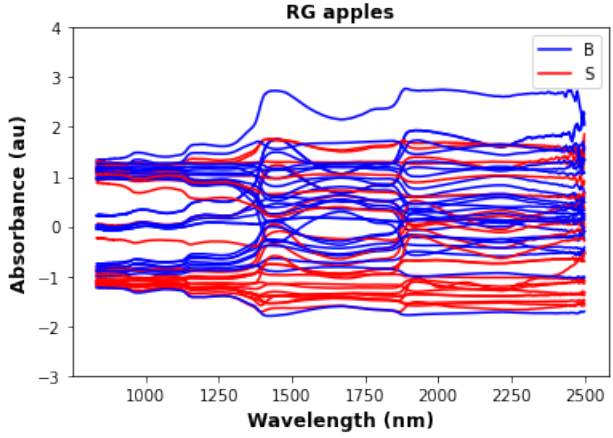
Figure 2. Infrared data after standardization for the same samples as in Figure 1.